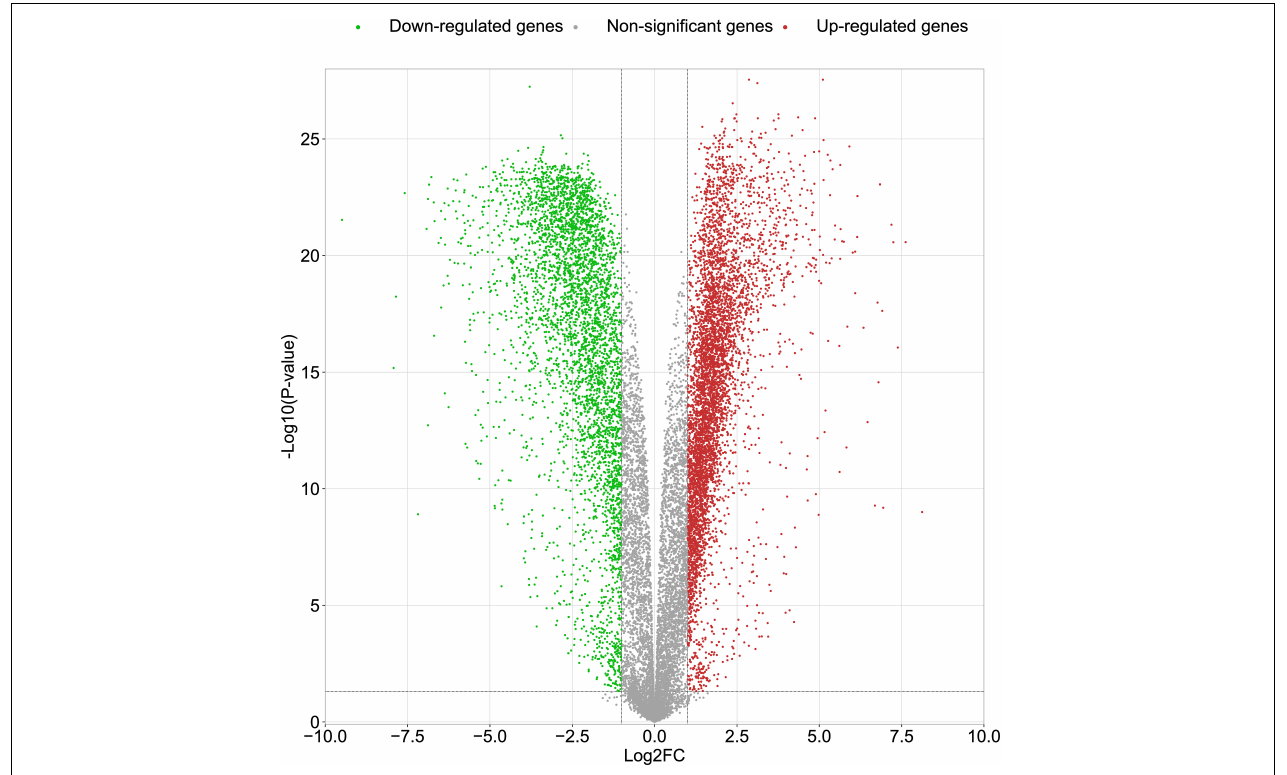
FIGURE 1 | Volcano plots of DEGs in the GSE109887 datasets. The abscissa indicates fold change (Log2FC). The ordinate indicates –log10 ( p value). Red dots indicate upregulated genes. Green dots indicate downregulated genes. Gray dots indicate non-significant genes.